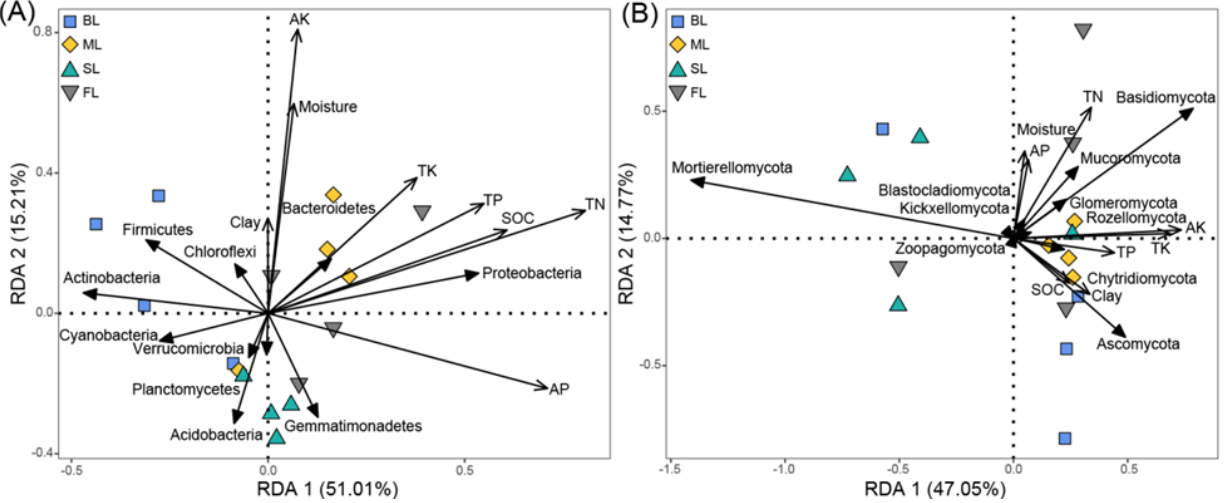
Figure 6. Redundancy analysis (RDA) biplot of bacterial ( A ) and fungal ( B ) community composition in different land-use types constrained by soil physicochemical properties. Abbreviations: FL,